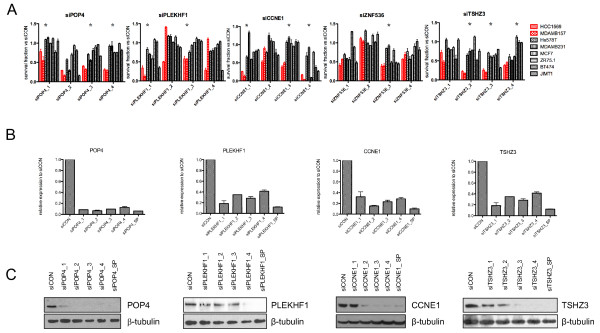
PLEKHF1, POP4 and TSHZ3 expression is selectively required for the survival of 19q12-amplified breast cancer cells. (A) Barplots illustrating the survival fractions of cancer cells with (red) or without (black) 19q12 amplification upon transfection with short interfering RNA (siRNA) targeting POP4, PLEKHF1, UQCRFS1, CCNE1, ZNF536, and TSHZ3 relative to siRNA controls (siCON) of individual duplex oligonucleotides (1 to 4). Error bars represent the standard error of the mean of three replicates. Reduced cell viability effects were considered validated if at least two individual oligonucleotides caused a significantly higher loss of viability of cancer cells harbouring 19q12 amplification than in those lacking amplification of this locus (* depicts significant t-test P-values for the comparison of the survival fraction between cells with and without amplification of the target gene for an individual oligonucleotide). siZNF536 failed to validate with two or more individual siRNA oligonucleotides. (B) Effects on target mRNA expression after silencing of PLEKHF1, POP4, TSHZ3 and CCNE1 with individual oligonucelotides in MDA-MB-157 cells as determined by quantitative RT-PCR. (C) Effects on target protein expression after silencing of PLEKHF1, POP4, TSHZ3 and CCNE1 with Dharmacon individual oligonucelotides and smartpool (SP) in MDA-MB-157 (CCNE1) and MCF7 cells (PLEKHF1, POP4, and TSHZ3) as determined by Western blotting.